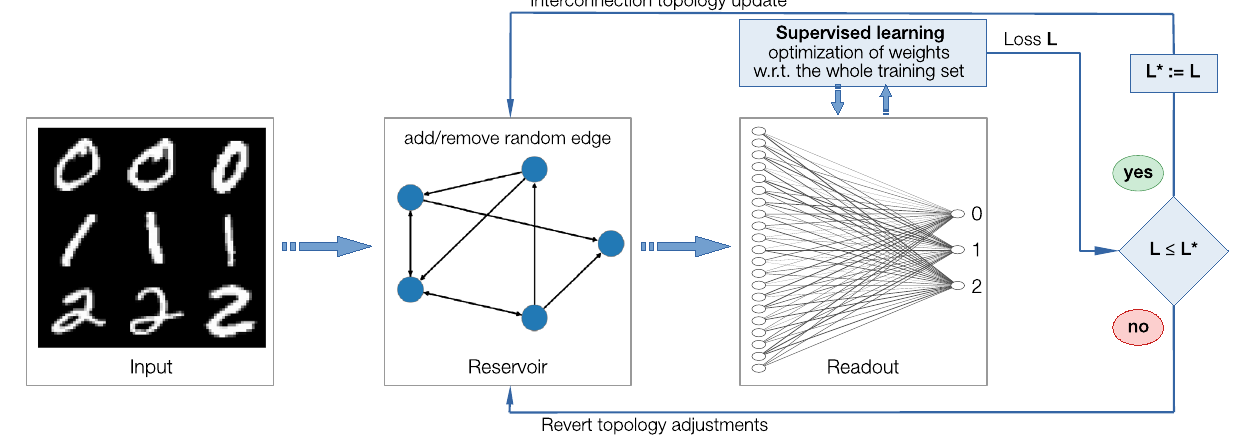
Figure 4. Scheme of the algorithm for the structural plasticity that is driven by the interaction of the reservoir (STOs network) with the environment (performance in solving hand-written digits classification task).